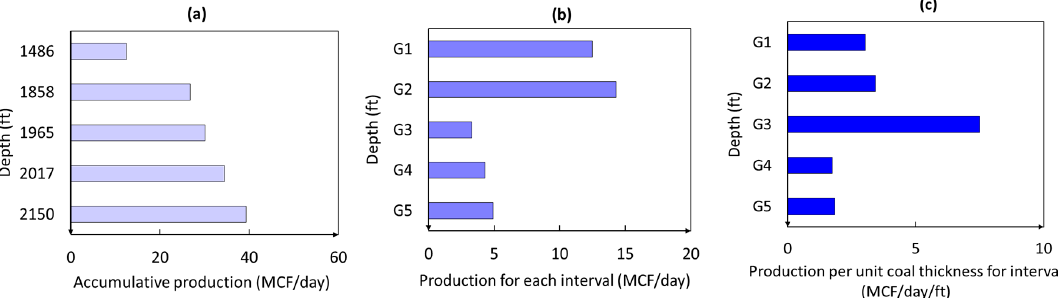
Figure 4. Gas production from each well kill test: ( a ) represents accumulative gas production from shallow coal seams to deep coal seams; ( b ) gas production at each coal seam interval, and ( c ) represents the gas production per unit coal thickness for each intervals.